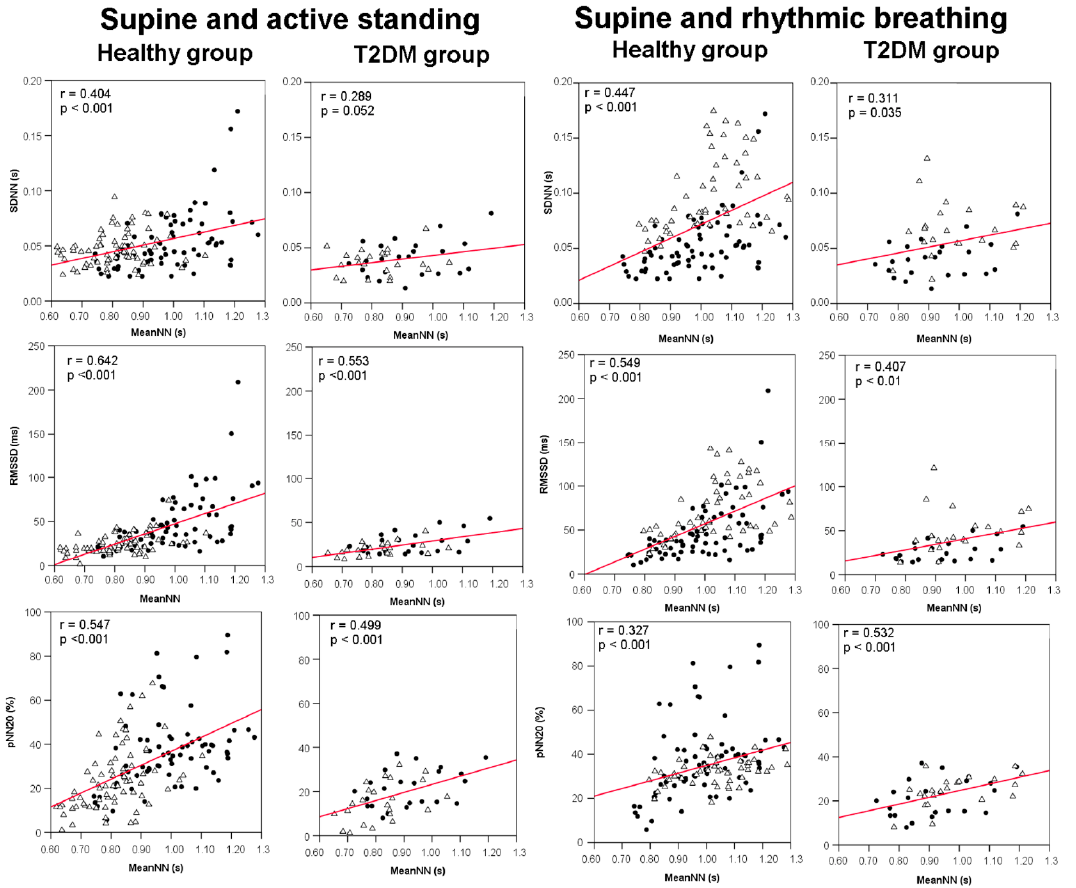
Figure 3. Dispersion plots between time domain HRV indices and meanNN in 44 healthy women (healthy group) and 19 female patients with type-2 diabetes mellitus (T2DM group). The plots on the left panels combine the HRV indices measured during both supine position (filled circles) and active standing (open triangles) of each group ( N = 88 for the healthy group and N = 38 for the T2DM group). The plots on the right panels combine the HRV indices measured during both supine position (filled circles) and rhythmic breathing (open triangles) of each group ( N = 88 for the healthy group and N = 38 for the T2DM group). MeanNN: mean value of all NN intervals; SDNN: standard deviation of all RR intervals; RMSSD: square root of the average of the squared differences between adjacent R-R intervals; pNN20: percentage of successive RR intervals with differences greater to 20 ms; r = Pearson’s correlation coefficient; p = p value.